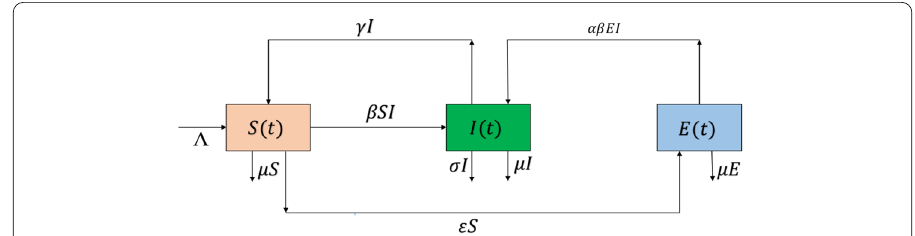
Figure 1 Flowchart of an SEI model with education. Humans are recruited into the susceptible class at a rate Λ . Susceptible individuals are infected by the infected persons at a per capita rate β SI and are educated at a per capita rate ε . Infected individuals recover to be susceptible again at a per capita rate γ . The educated individuals are infected at a reduced per capita rate αβ EI due to ineffective educational intervention strategies. Per capita natural death rate and death rate due to jigger infestation are represented by μ and σ ,